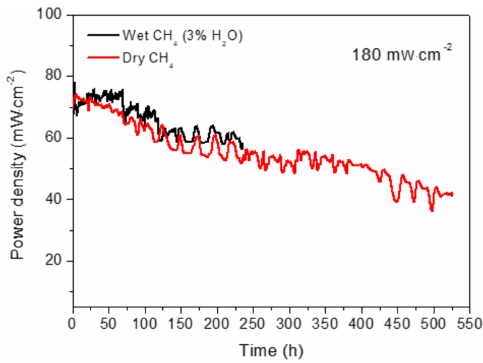
Figure 3. Long-term stability of the cell (Ni-CYSZ / YSZ / LSM) operating under a constant current density of 180 mA · cm − 2 in wet (3% H 2 O) and dry CH 4 at 850 ◦ C.